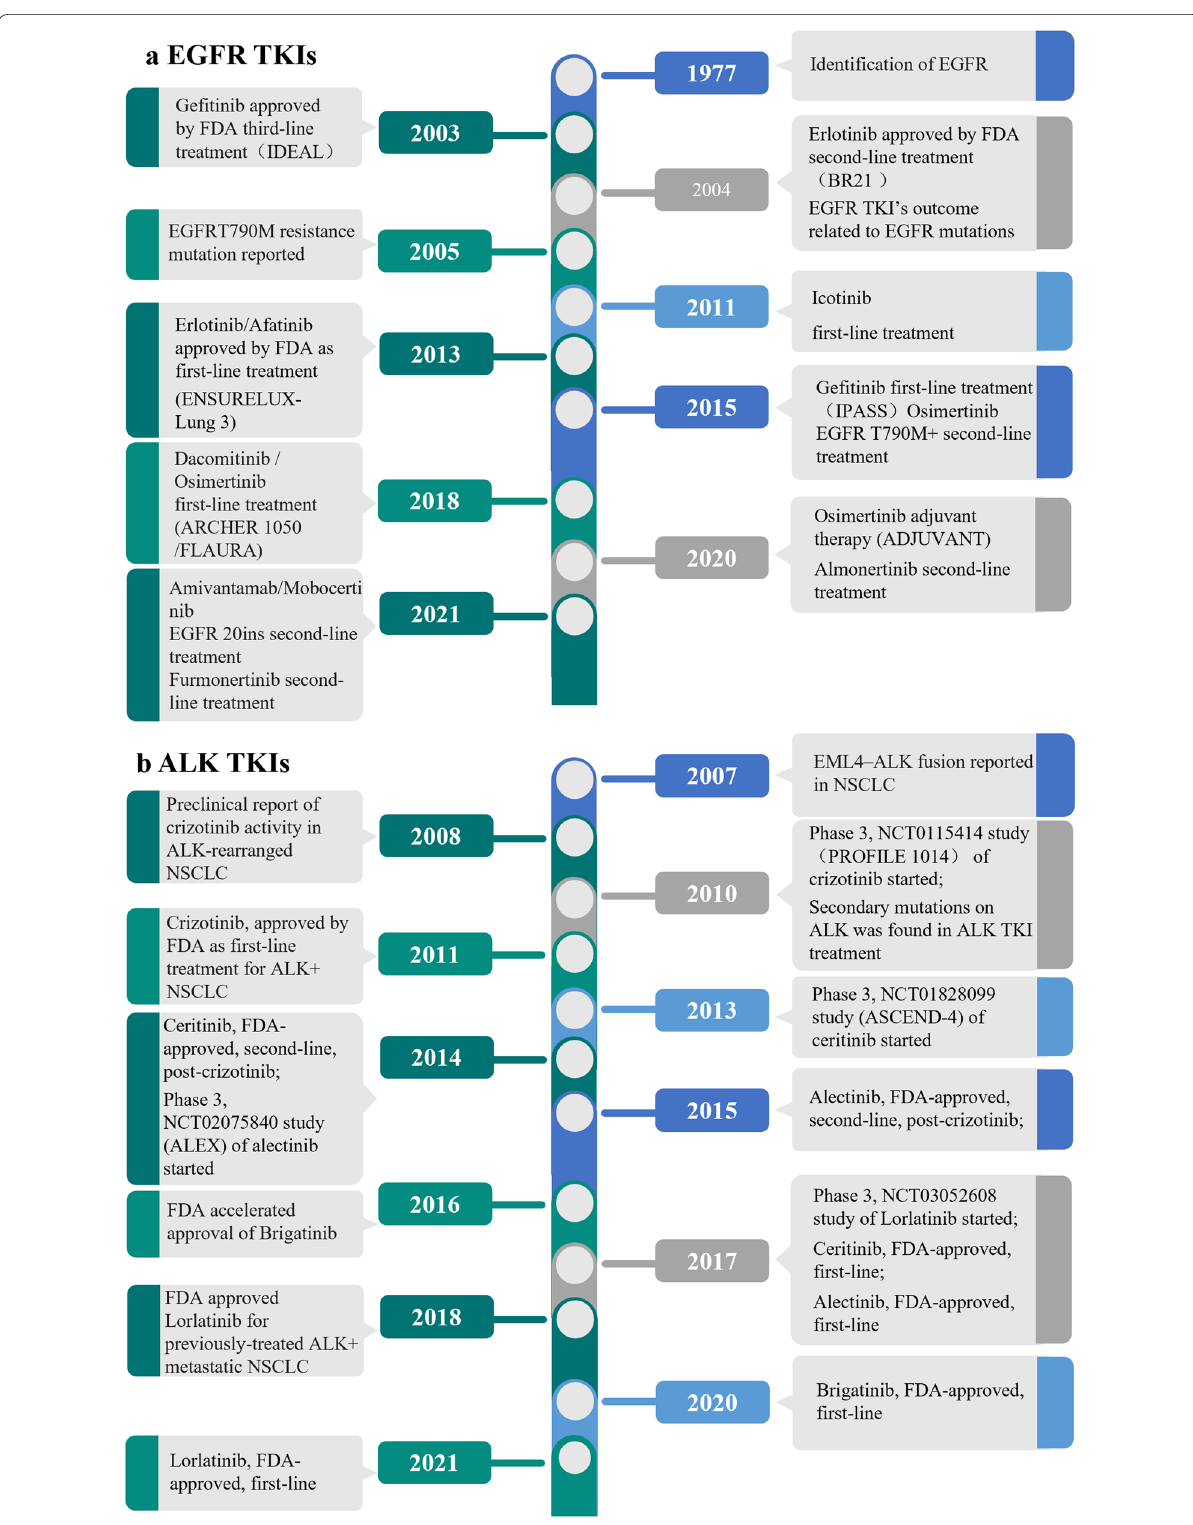
Fig. 1 Development history in targeted therapy for NSCLC of EGFR TKIs and ALK TKIs. Timeline of breakthrough in EGFR-mutant NSCLC (part a) and ALK-positive NSCLC (part b). EGFR, epidermal growth factor receptor; ALK, anaplastic lymphoma kinase; NSCLC, non-small-cell lung